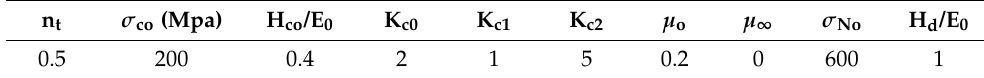
Table 12. Values of the remaining ten LDPM